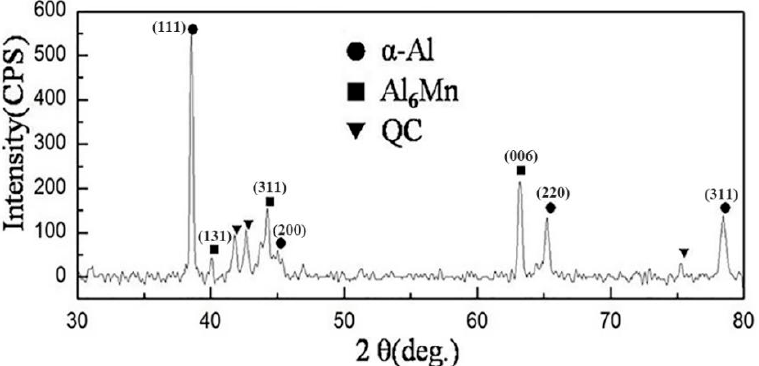
Figure 12. XRD pattern of suction casting Al–10 wt.% Mn alloy.